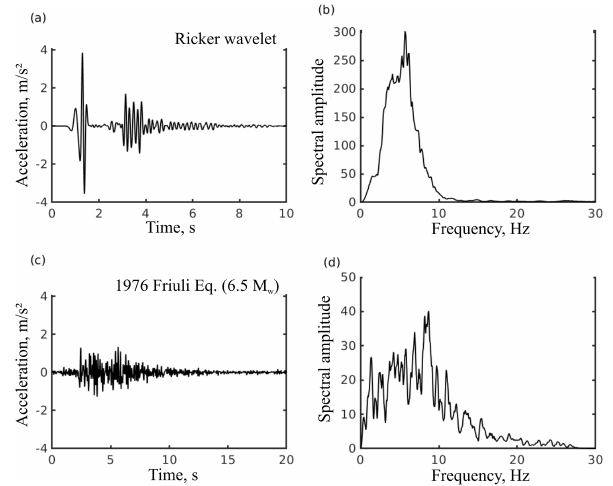
Figure 7. Seismic signals in the time and frequency domain. (a, b) Ricker wavelet (as recorded at the model base monitor- ing point); (c, d) 1976 Friuli earthquake (Italy). Note the different